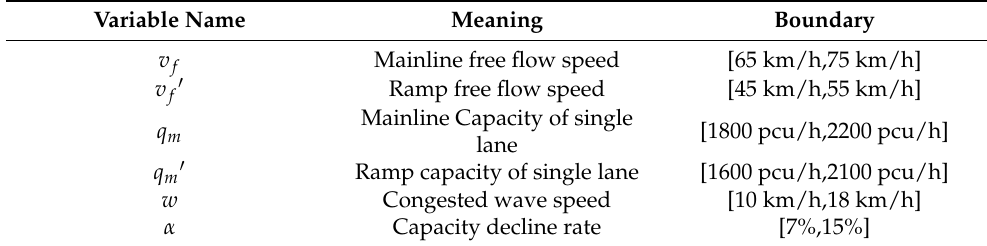
Table 2. Parameter range of genetic variables.